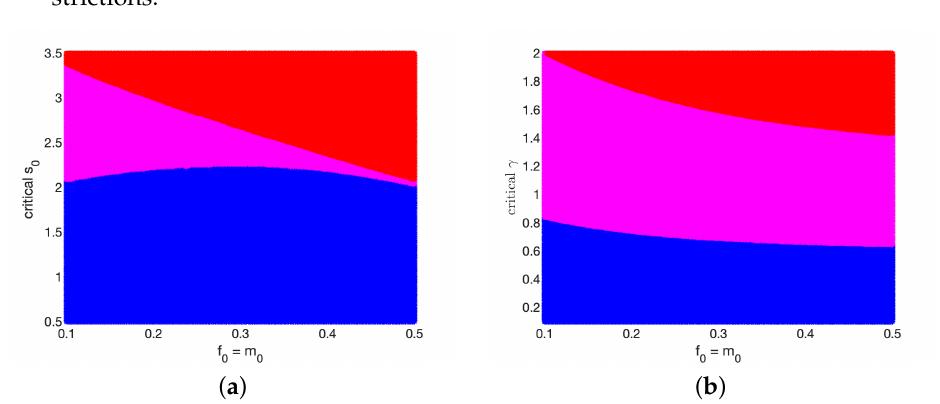
Figure 2. In these simulations we consider the three species TYC PDE model (6)–(8) with Neumann boundary conditions. The phase space is partitioned into three regions showing various dynamics. The blue region in ( a , b ) indicates where positive solutions are guaranteed for f and m where s ( 0 ) < s ∗ and γ < γ ∗ . The magenta region shows where negative solutions for m exist mathematically for s ∗∗ > s ( 0 ) ≥ s ∗ and γ ∗∗ > γ ≥ γ ∗ . In this region, f converges asymptotically to zero in ( a ) and f goes to a non-negative steady state in ( b ). The red region in ( a , b ) indicates where negative solutions for m exist and f blows-up in finite time for s ( 0 ) ≥ s ∗∗ and γ ≥ γ ∗∗ . In each simulation in ( a ), γ = 0 and in ( b ), s ( 0 ) = 0. Simulation uses D = 1 and ρ =